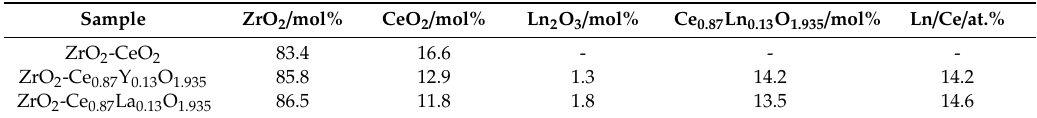
Average macroscopic chemical composition for the fresh undoped and Ln-doped ZrO 2 -CeO 2